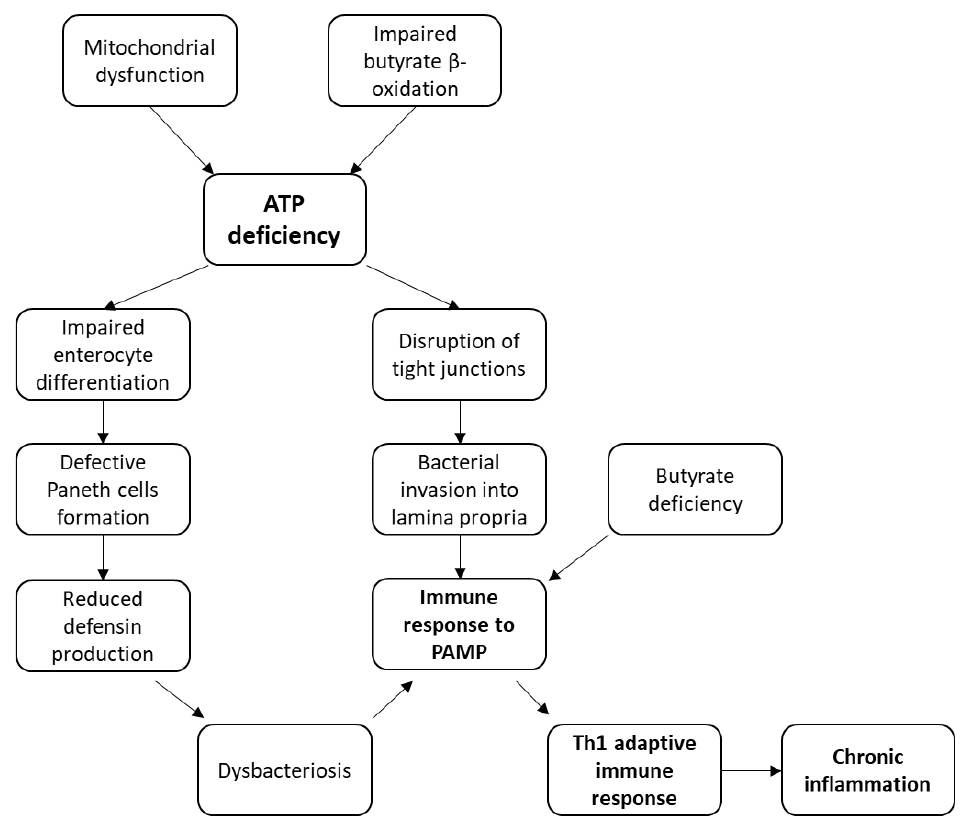
Figure 1. Models of CD pathogenesis with inflammation induction by PAMP.